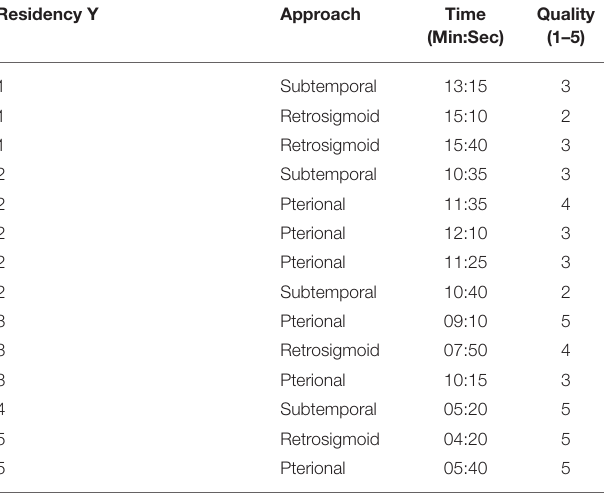
TABLE 3 | Descriptive results regarding time, procedures, and quality of exercises.